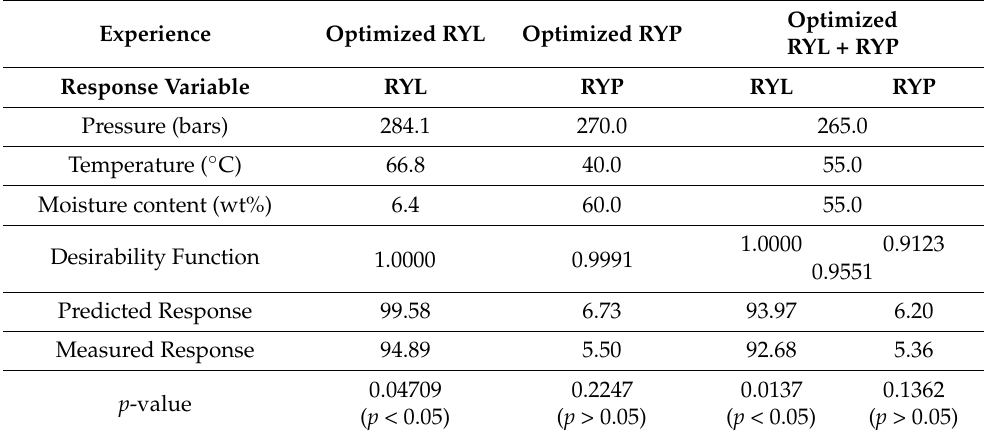
Table 4. Optimization of RYL, RYP, and RYL/RYP simultaneously with Derringer’s desirability function (DF).